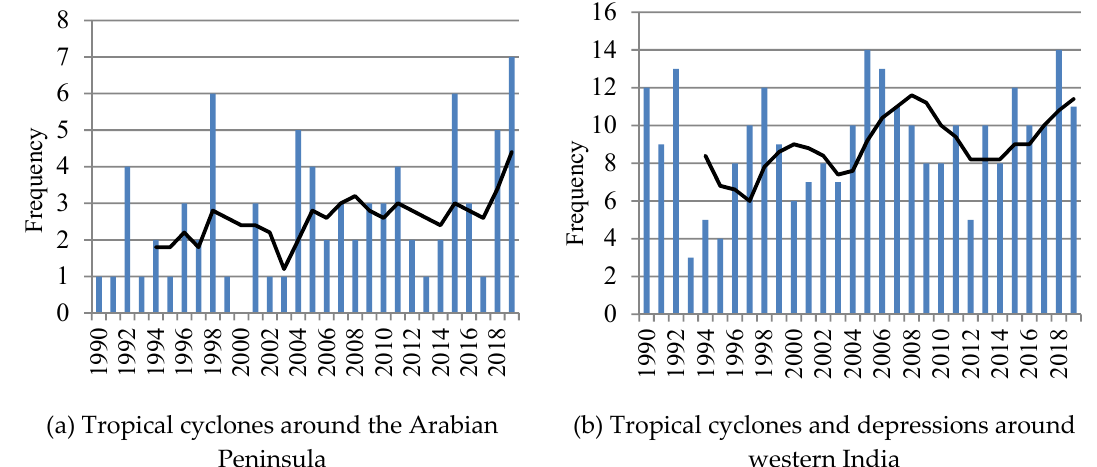
Figure 9. Trend in tropical cyclone and depression frequencies during 1990–2019; the trend line is the five-year moving average.